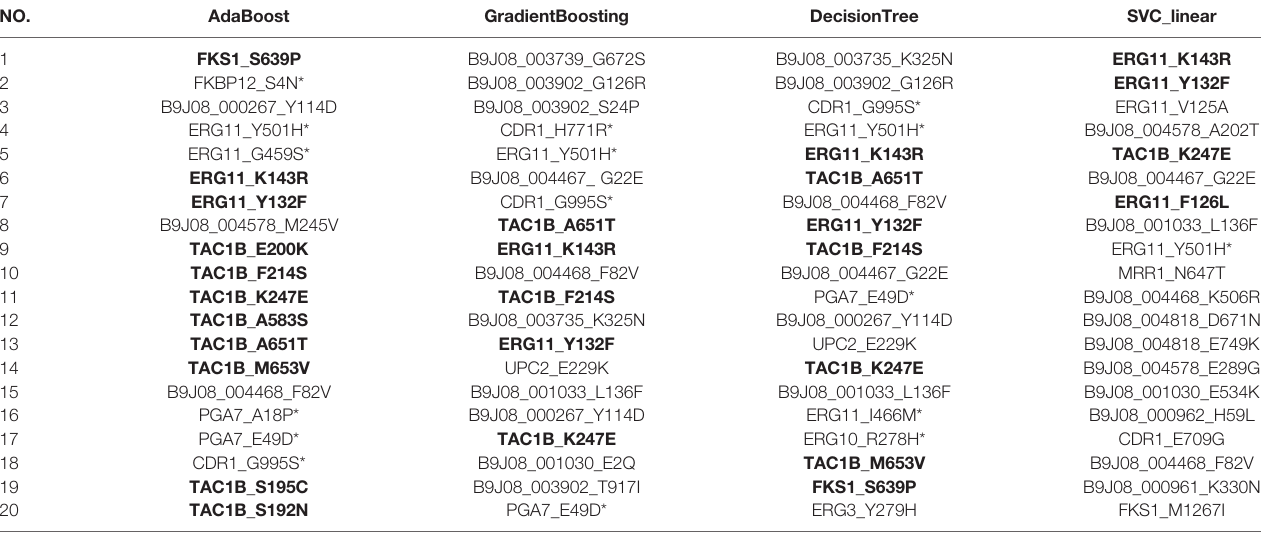
TABLE 3 | Top 20 mutations ranked by RFECV for FCZ on F1 set.